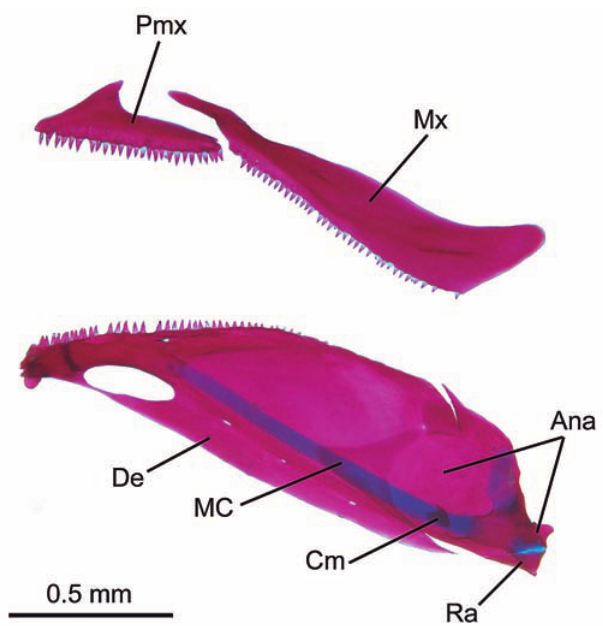
Fig. 2. Priocharax nanus , paratype, MZUSP 114018, 13.2 mm SL, c&s; jaws in lateral view illustrating dentition. Ana = anguloarticular; Cm = coronomeckelian; De = dentary; MC = Meckel’s cartilage; Mx = maxilla; Pmx = premaxilla; Ra = retroarticular. Scale bar = 0.5